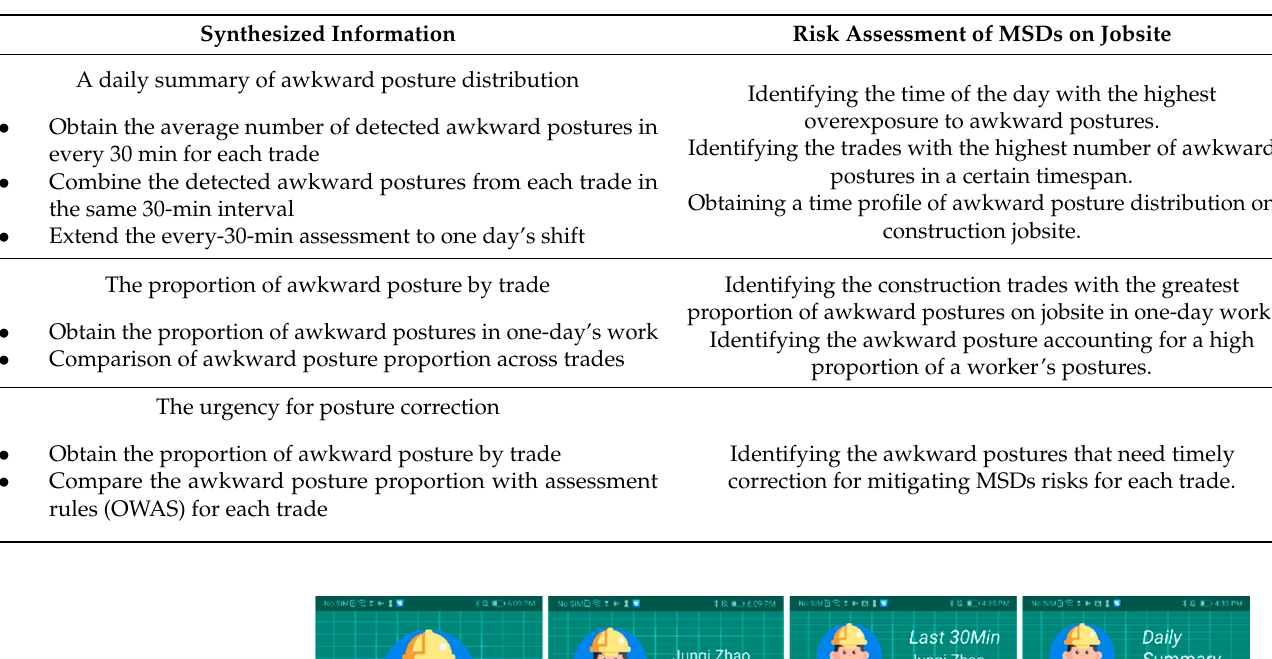
Table 4. Periodic MSDs risk assessment on jobsites.